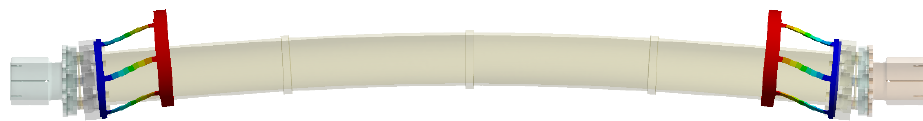
Figure 9. Finite element obtained first bending mode of shaft with medium sleeve.